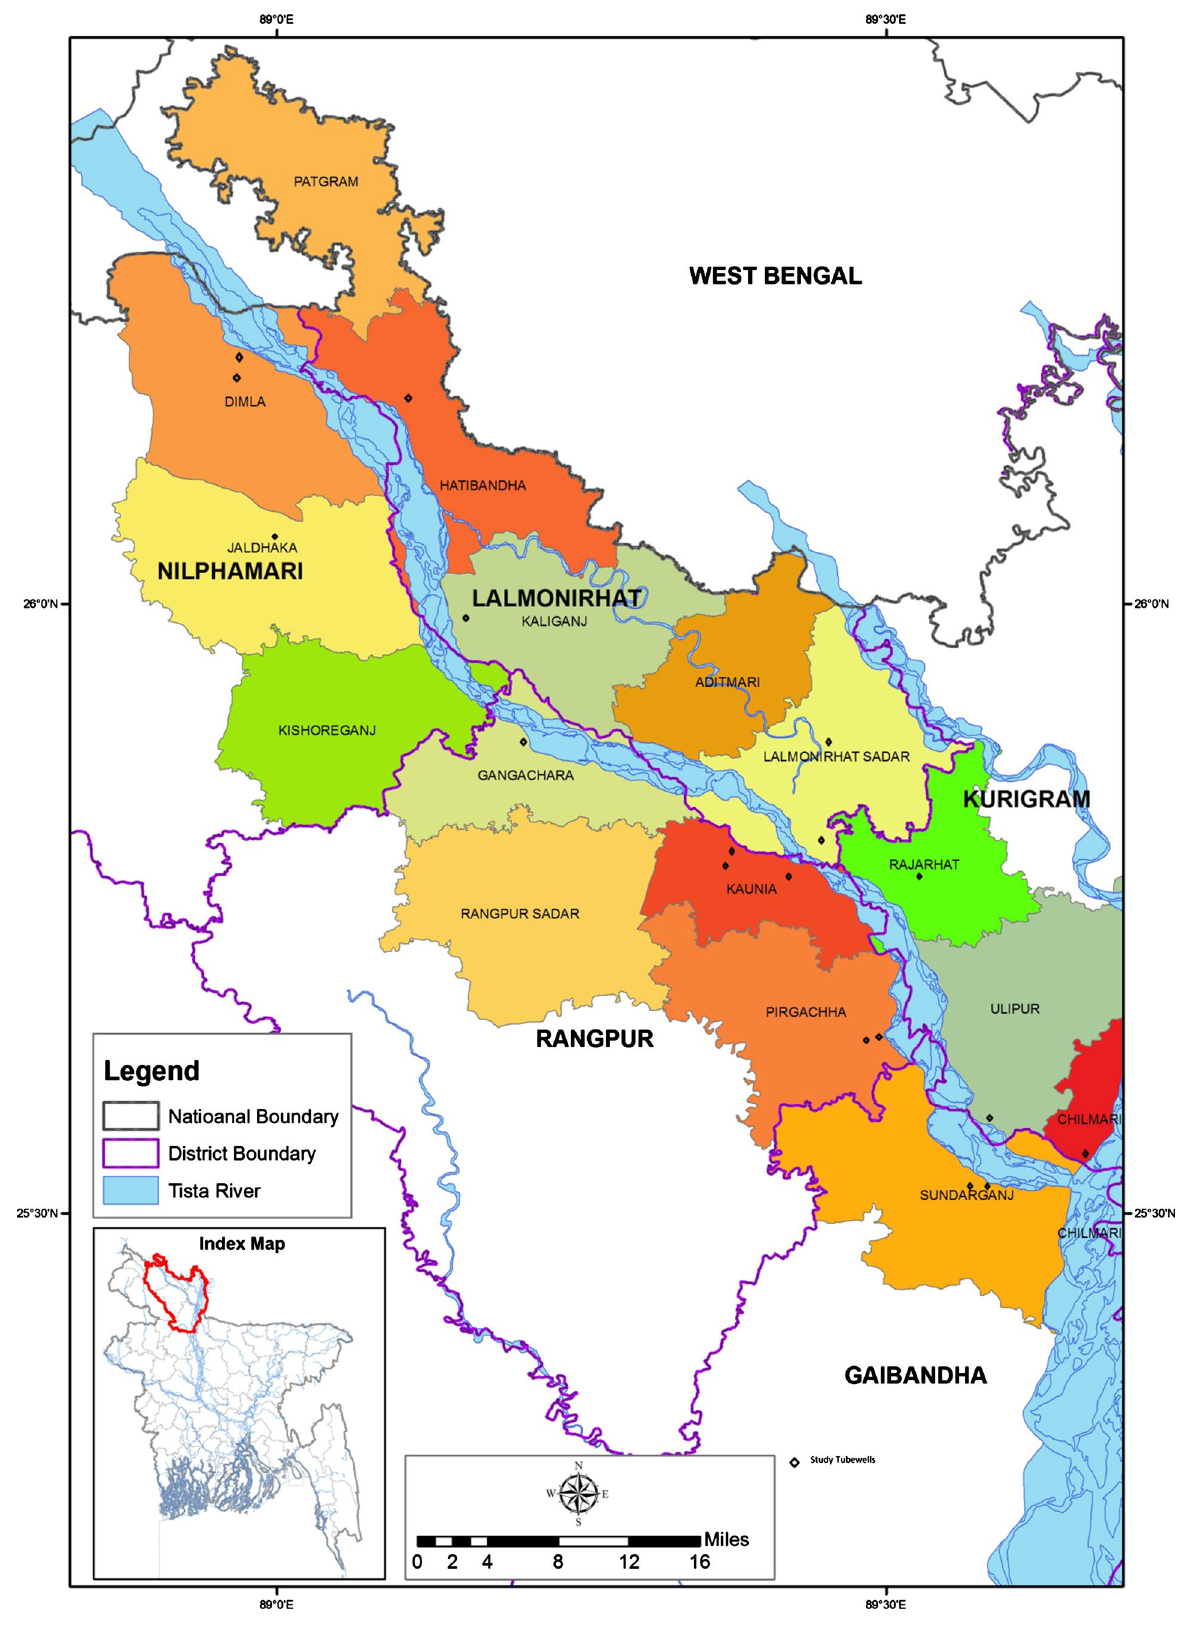
Fig. 1 Map of the study